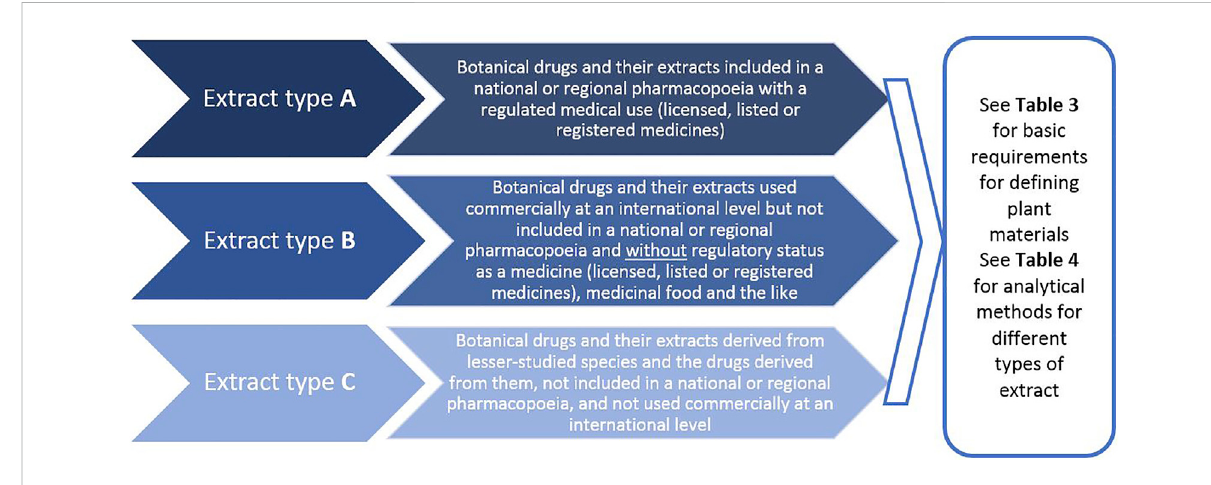
FIGURE 6 Classi fi cation of medicinal plant extract used in pharmacological, toxicological, and clinical/intervention research (see Table 3 for basic requirements for de fi ning the plant material, and Table 4 for analytical methods of different types of extracts) — a novel way for guiding the requirements for extract